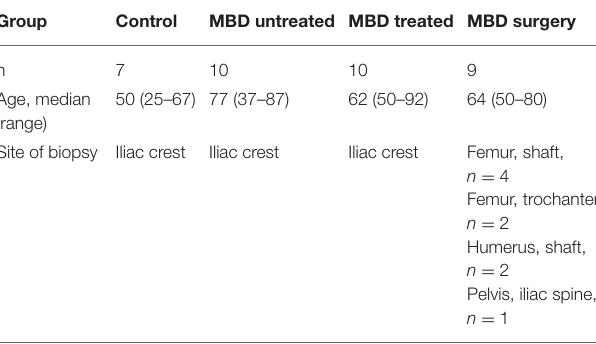
TABLE 1 | Patient